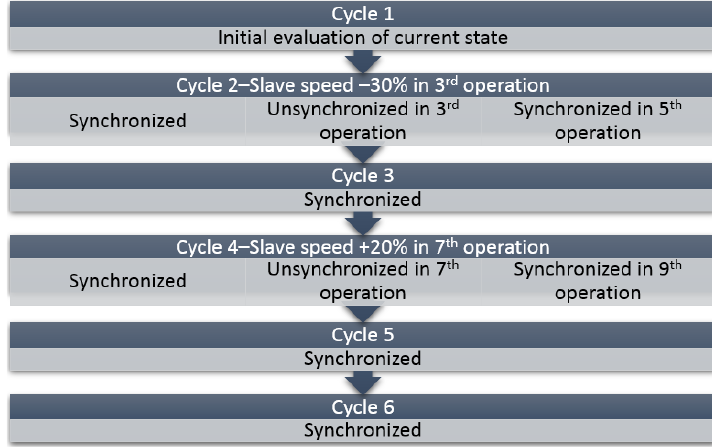
Figure 14. Percentage proportion deviation with feedforward synchronization — Experiment 2b. Appl. Sci. 2020 , 10 , x FOR PEER REVIEW